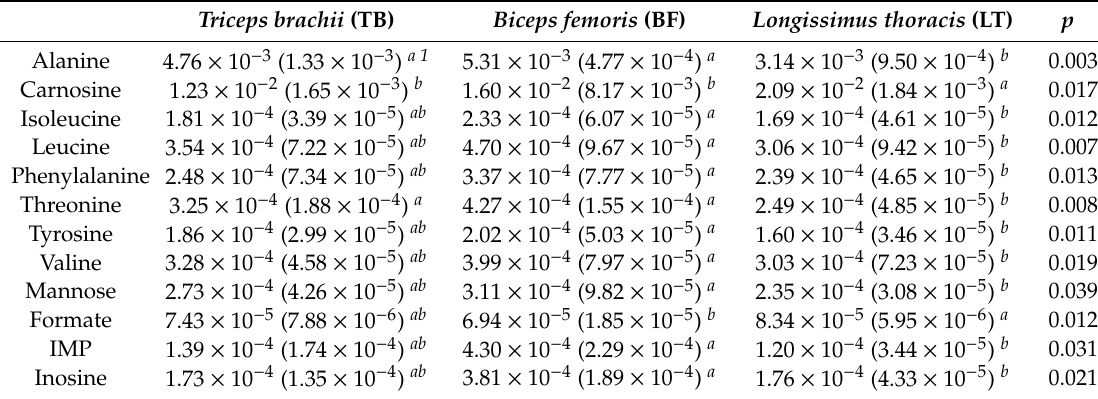
Table 1. Molecules in yak raw meat with a concentration (mmol / g, median (IQR)) significantly di ff erent among muscle types.